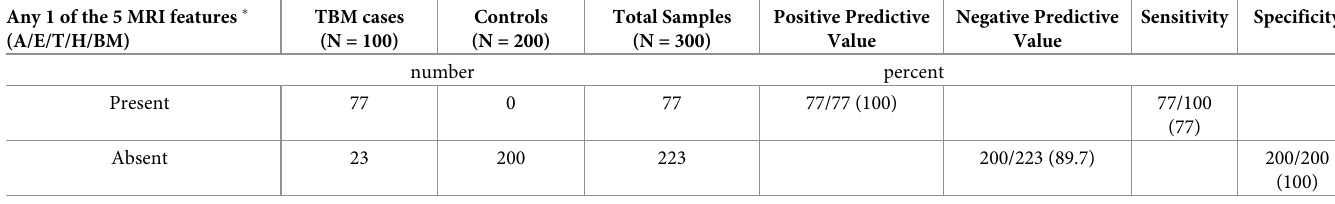
Table 3. Sensitivity and specificity of MRI with A/E/T/H/BM for TBM. Any 1 of the 5 MRI features � (A/E/T/H/BM)